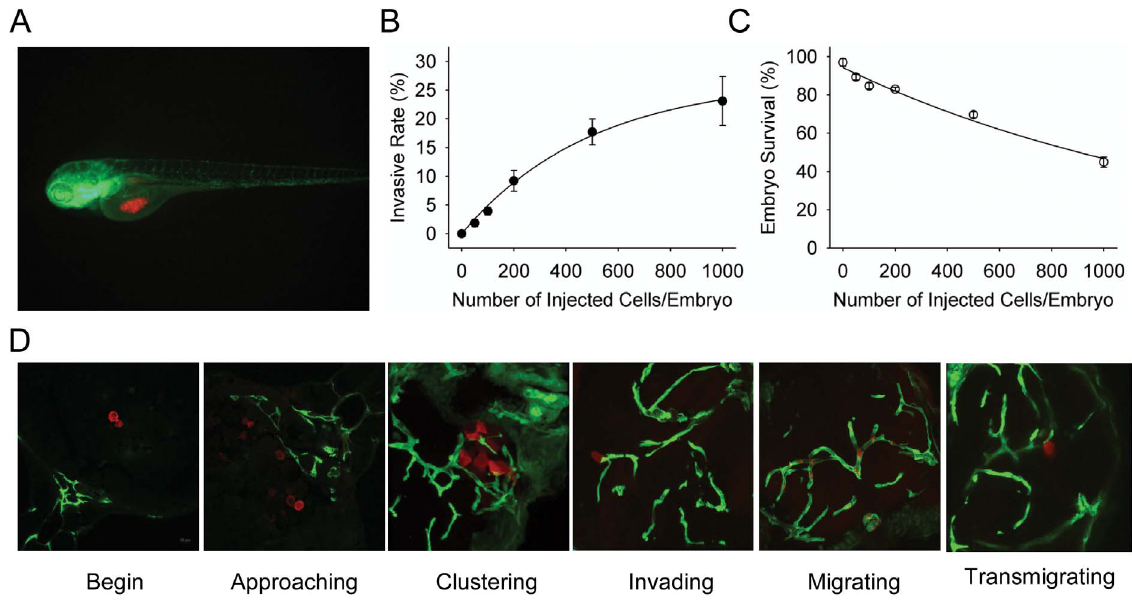
Figure 1. The establishment of U87 glioma sphere cell invasion model in zebrafish embryos. A. Dual color confocal image shows that U87 sphere cells (RFP labeled, red) were microinjected into the middle of yolk sac within Tg ( fli1 :EGFP) y1 transgenic zebrafish embryos (EGFP labeled, green). B. Different numbers of U87-RFP glioma sphere cells were microinjected into Tg ( fli1 :EGFP) y1 embryos (n=300 in each group), and the percentage of embryos with invasive tumor cells was quantitated. C. The survival rate of Tg ( fli1 :EGFP) y1 zebrafish embryos microinjected with different numbers of U87-RFP glioma sphere cells (n=300 in each group). D. Representative dual color confocal images of RFP-labeled U87 sphere cells within Tg ( fli1 :EGFP) y1 zebrafish embryos at the different invasive stages. Red: RFP-labeled U87 sphere cells; Green: Tg ( fli1 :EGFP) y1